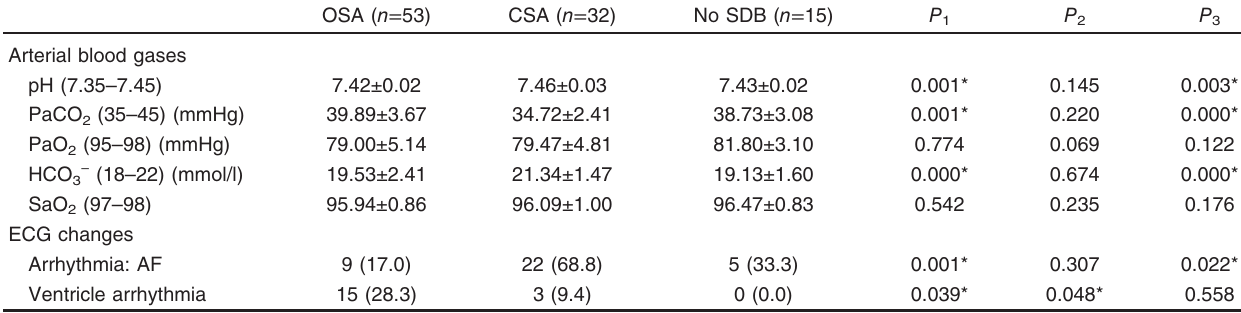
Table 4 Comparison in arterial blood gases and electrocardiography changes between each of obstructive sleep apnea, central sleep apnea, and no sleep-disordered breathing groups with heart